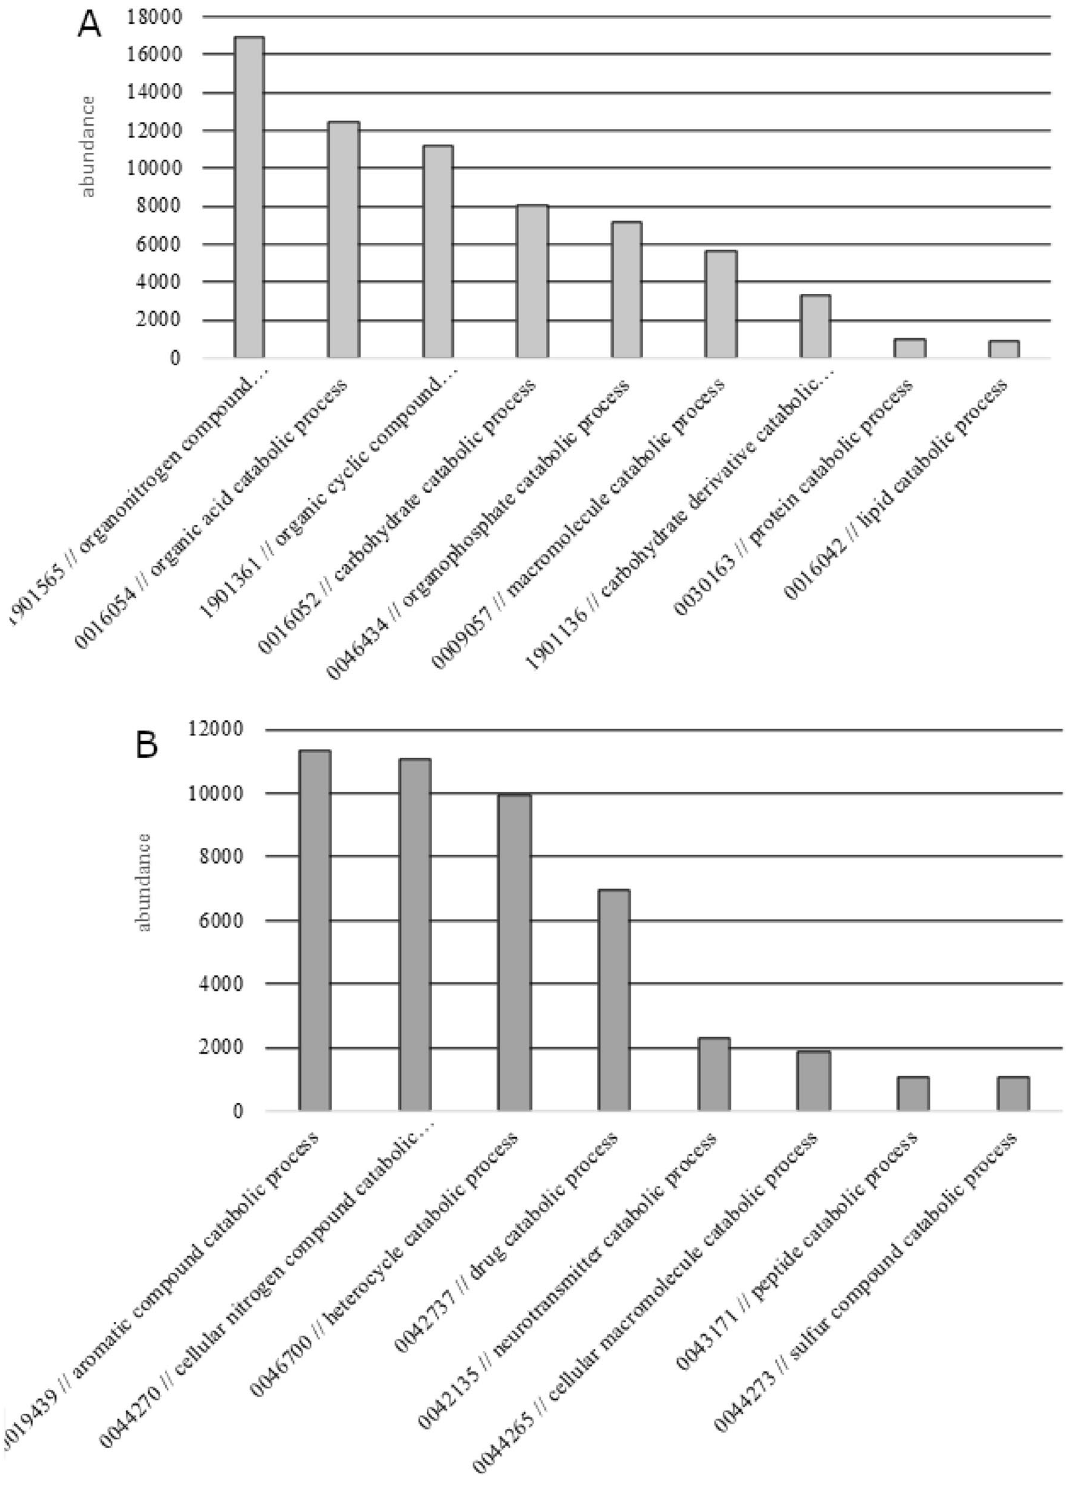
Figure 6. Gene abundance of selected GO terms in P. psychrophila KM02 genome. ( A ) Selected child terms of ‘organic substance catabolic process’ GO term. ( B ) Selected child terms of ‘cellular catabolic process’ GO